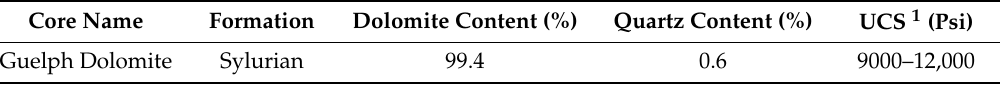
Table 1. Guelph Dolomite core plugs general